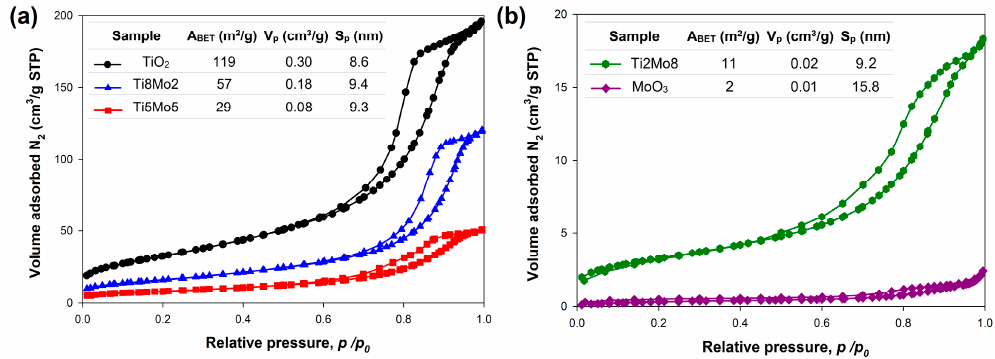
/ desorption isotherms for analyzed Figure 7. N 2 adsorption/desorption isotherms for analyzed materials. Figure 7. N 2 adsorption